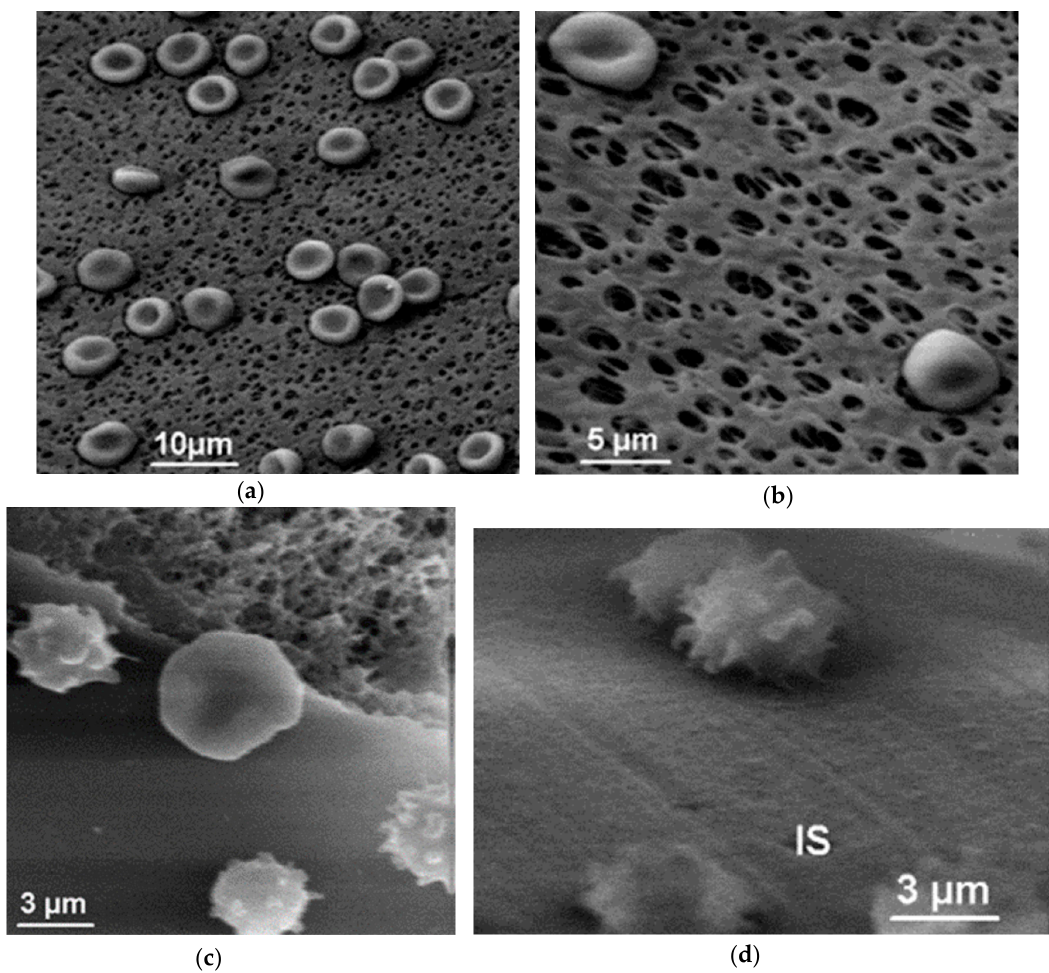
Figure 14 . EM of RBCs adsorbed onto the different surfaces of a polysulfone capillary: ( a ) outer surface of the capillary; ( b ) zoomed image; ( c ) inner surface of the capillary (electron microscopy), where the polymer capillary is dissected along the long axis, then flattened and attached to the support; and ( d ) zoomed image of echinocytes on the inner surface (IS) of the capillary. (Electron microscopy: REMMA-101A, AO “SELMI”, accelerating voltage 20 kV. Red blood cells: washed in phosphate buffer pH 7.2, fixation 2% glutaraldehyde (SPI, USA), dehydration in alcohol range 2–98%).